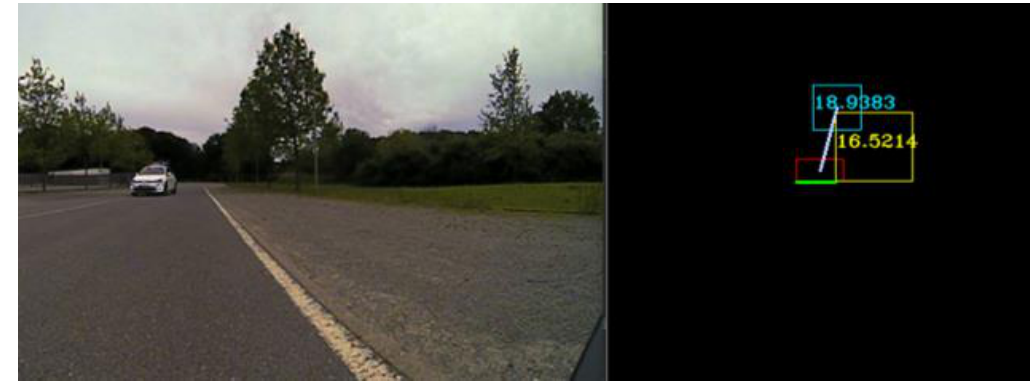
Figure 8. Correspondence of the trifocal camera objects and LIDAR and RADAR sensor measurements. On the left-hand side, the color image captured by the camera is shown. On the right-hand image, the data association of objects from different sensors is illustrated.